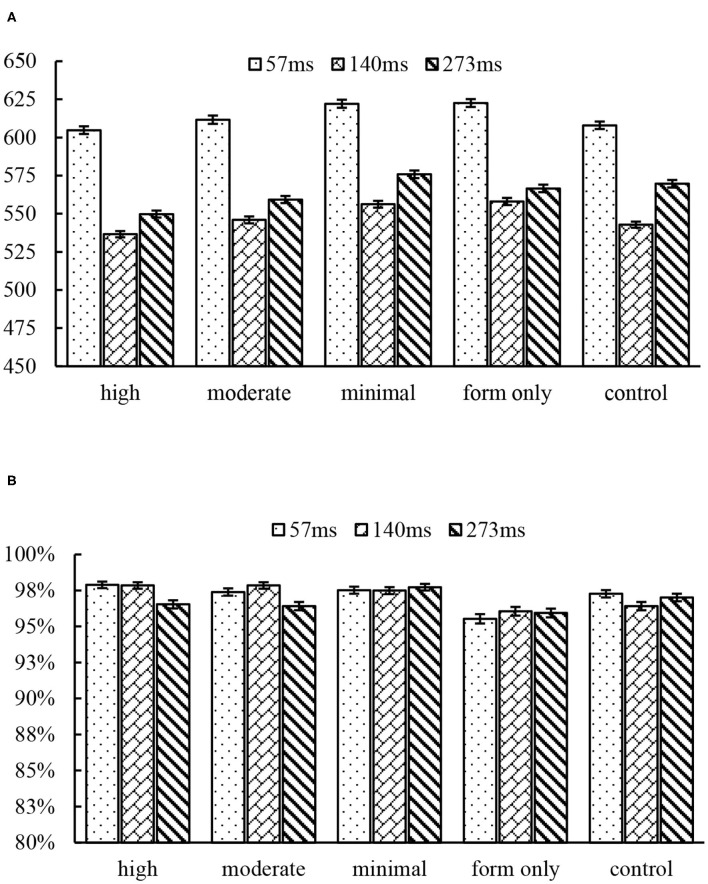
The mean reaction time (ms) (A) and accuracy (B) by conditions and SOA. Error bars indicate standard error.